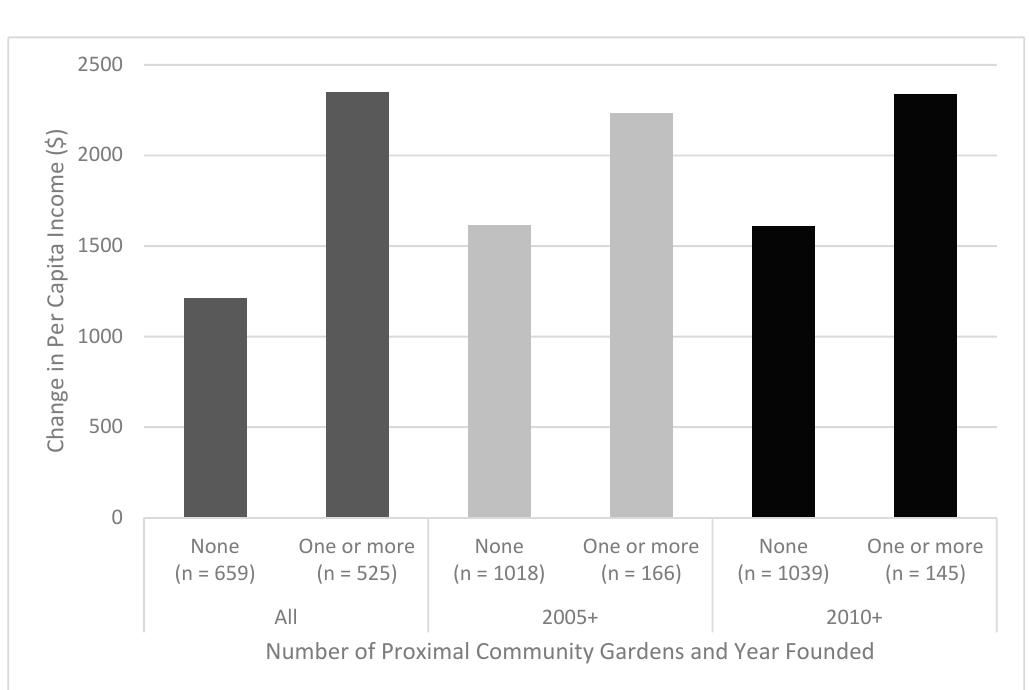
Figure 6. Population-weighted average change in per capita income (2010–2015) vs. proximity to one or more community gardens. Community gardens were categorized as founded in any year (all), those founded in 2005 or later (2005+), and those founded in 2010 or later (2010+).